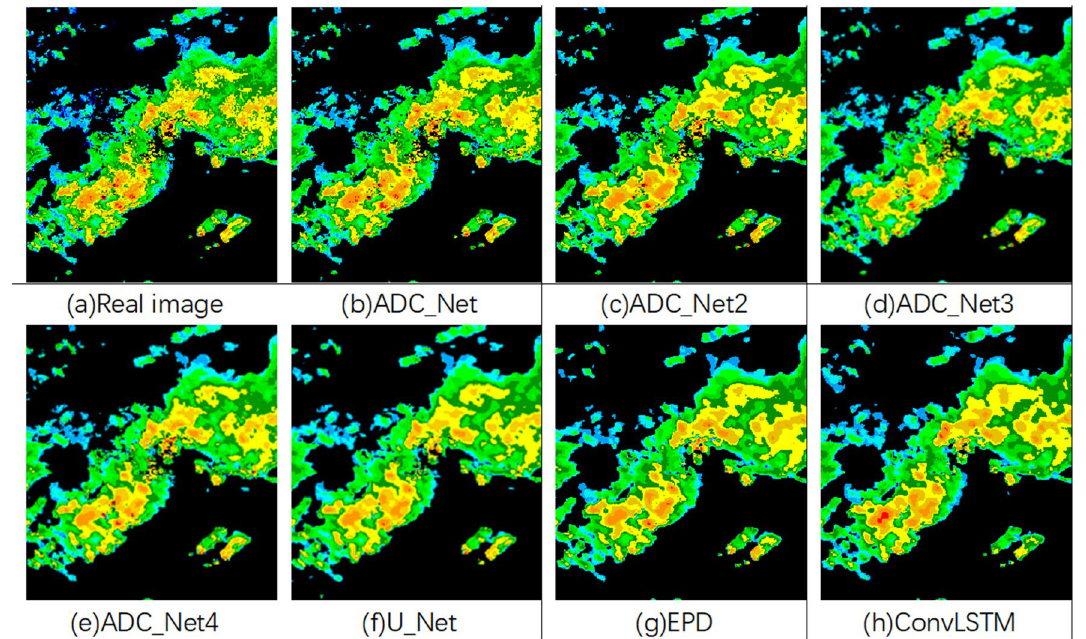
Figure 8. Comparison of model radar echo extrapolation results.